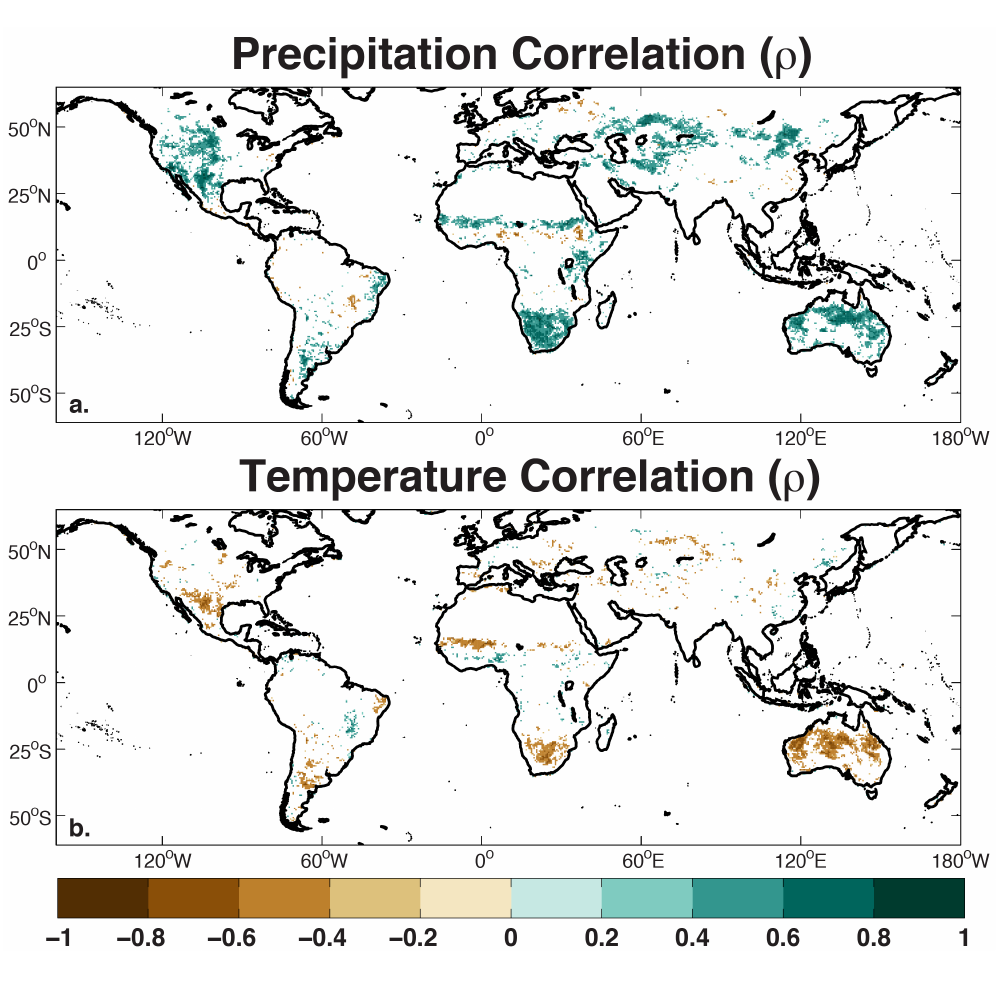
Figure 4. Correlation (Spearman’s ρ ) between LAImax of pasture cells and ( a ) annual total precipitation and ( b ) annual mean temperature for 1982–2008. Insignificant correlations ( p > 0 . 05 ) have been masked out. Correlations are based on linearly detrended time series of LAImax, temperature, and